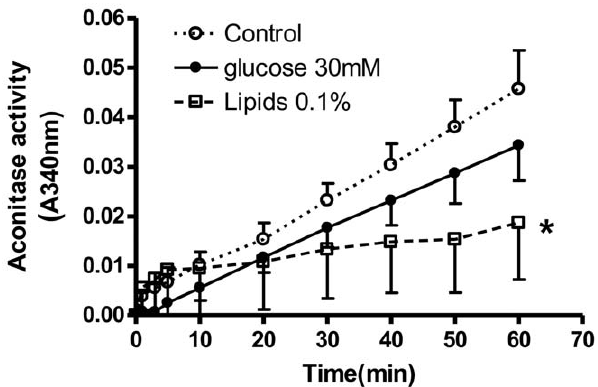
Figure 5. Aconitase activity in BAE cells exposed to antecedent glucose and lipid. Enzyme activity was determined in mitochondria isolated from BAE cells exposed to 5 mM glucose (control), 30 mM glucose, or 5 mM glucose plus 0.1% Intralipid (see text for composition) for 24 h. Activity was determined as NADPH production (A340nm) from cis-aconitate in the presence of exogenous isocitrate dehydrogenase monitored over 60 min. * p , 0.05 compared to control by 2-way ANOVA, n=6 per group.